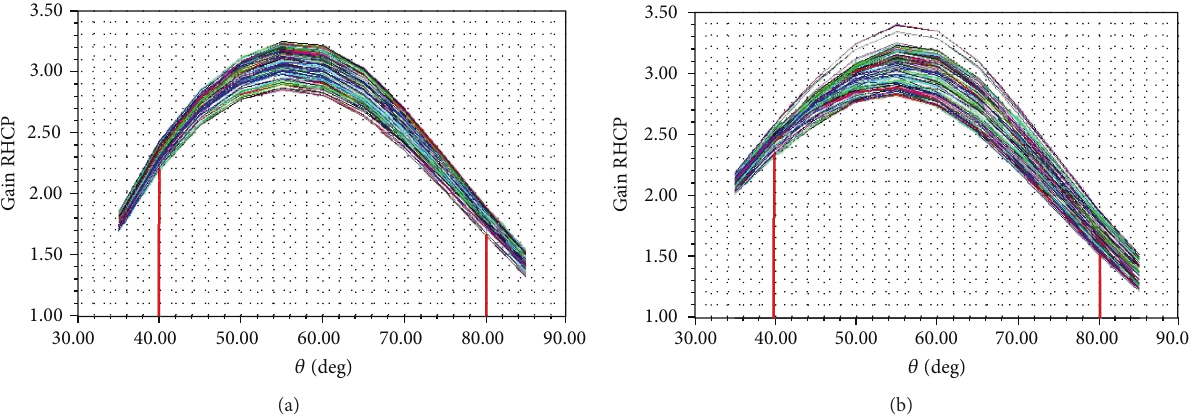
Figure 5: RHCP gain at 8470 MHz frequency: (a) for the roughly evolved antenna and (b) for the orthogonally designed